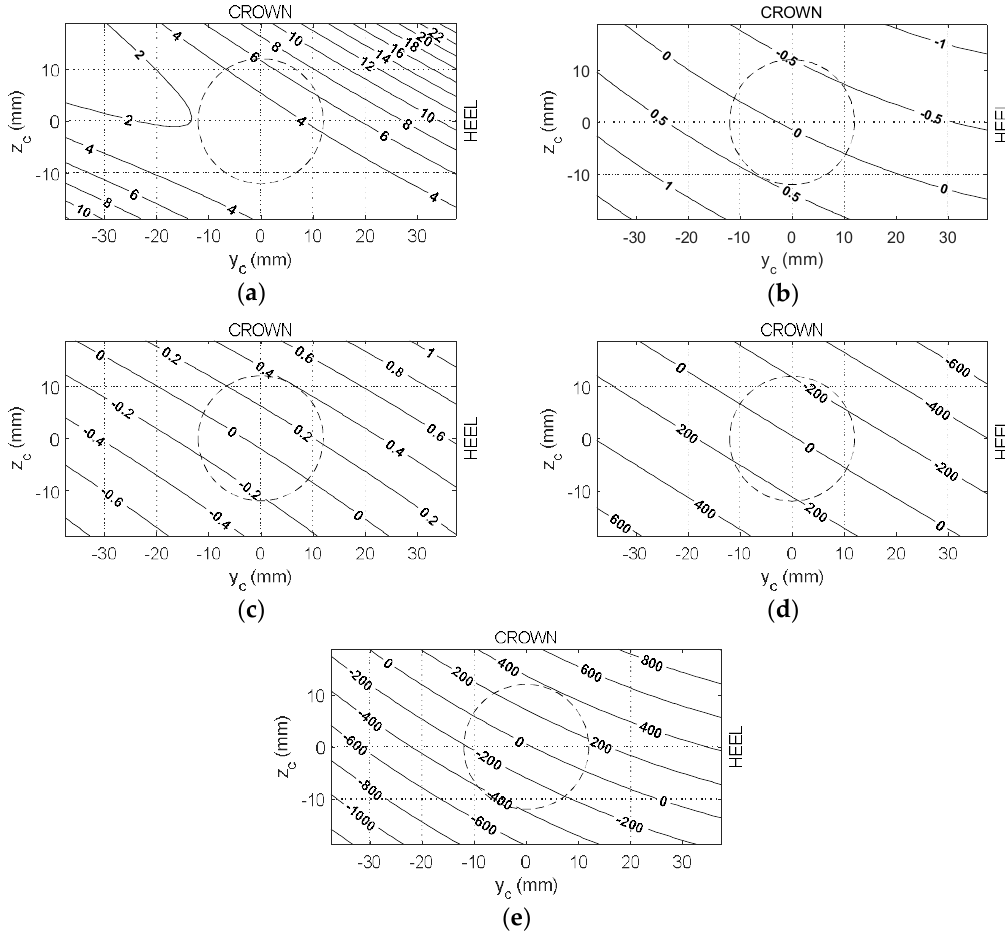
Figure 5. Launch condition differences across the clubface ( full-club–free-body ). ( a ) Ball speed (km/h); ( b ) Launch Angle (deg); ( c ) Azimuth (deg); ( d ) Side Spin (rpm); ( e ) Back Spin (rpm)